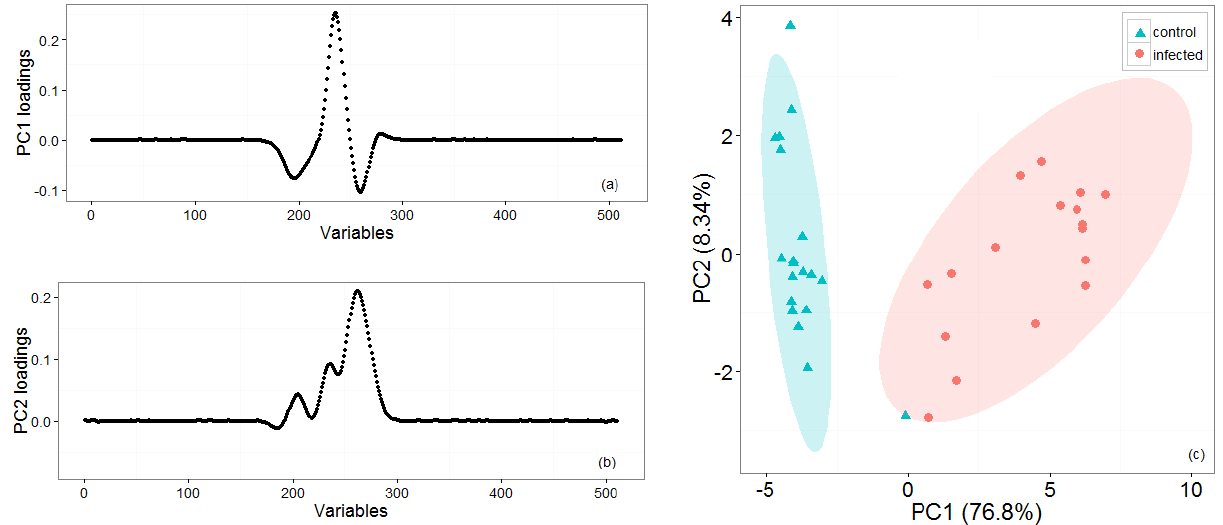
Figure 5. Third set of experiments: Loading plots ( a , b ) for the two first principal components that account for most of the variance. ( c ) PCA and k-means clustering for two groups of potato tubers with controls (cyan triangles) and infected (red circles) that have been grouped with 95% confidence ellipses around the centroid identified by the k-means algorithm.